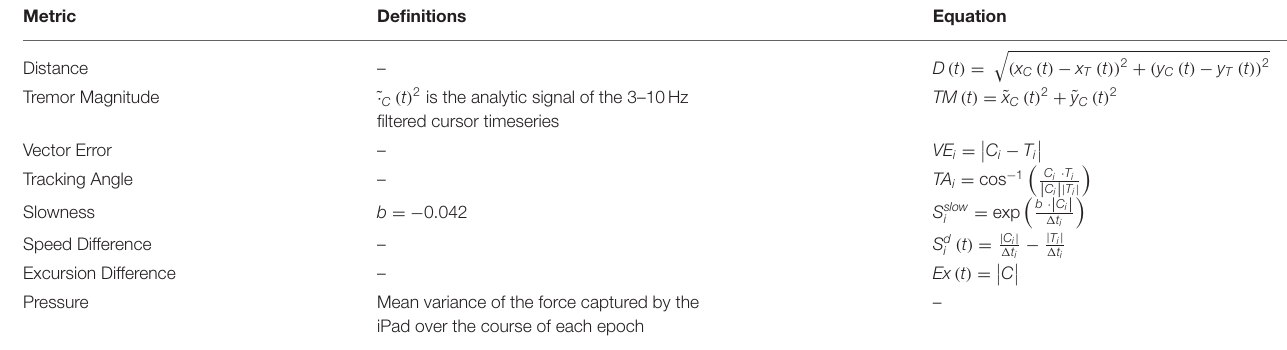
TABLE 2 | Equations used to calculate metrics used to train the SVM